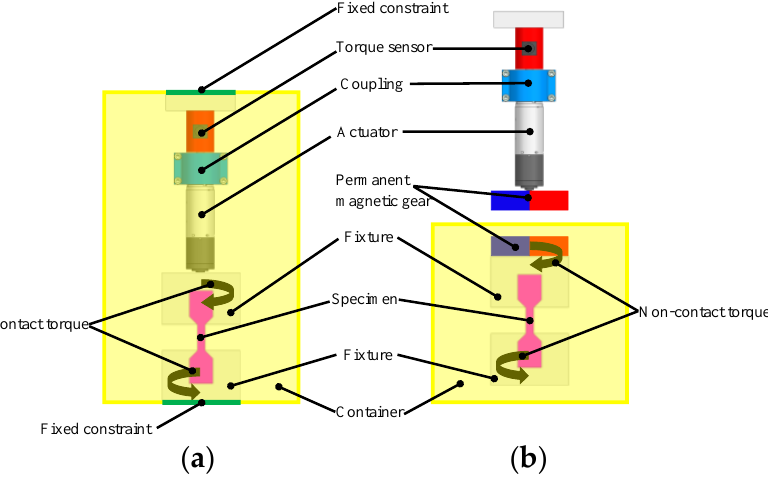
Figure 1. Schematic diagram: ( a ) Traditional torsion testing mechanism; ( b ) Noncontact torsion testing mechanism.